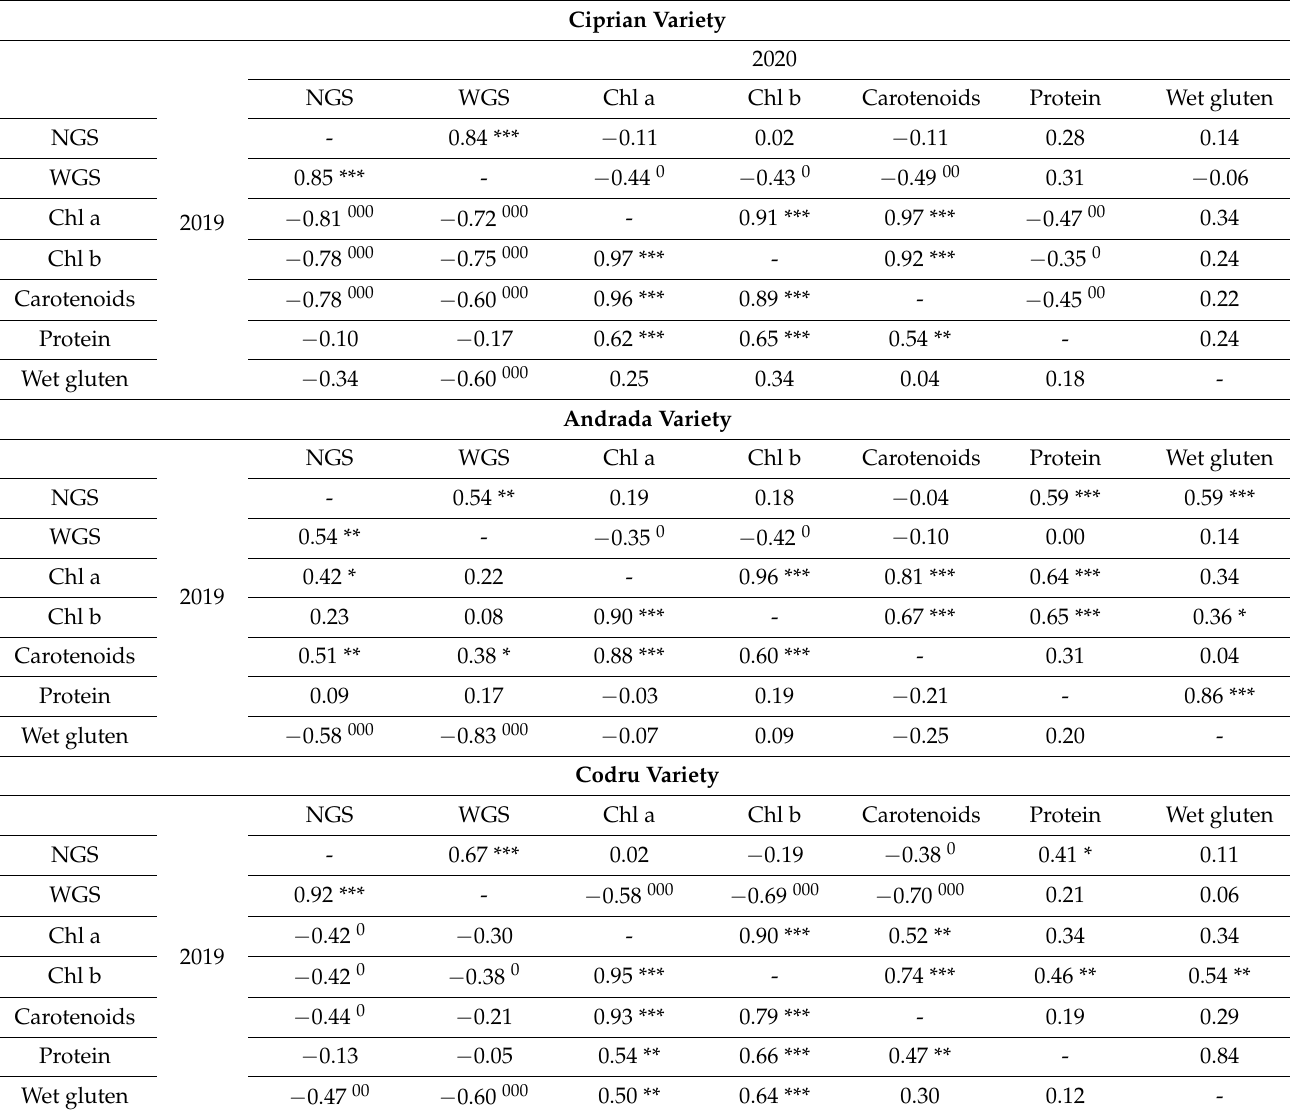
Table 3. Pearson correlation between analyzed traits for both experimental years. Ciprian